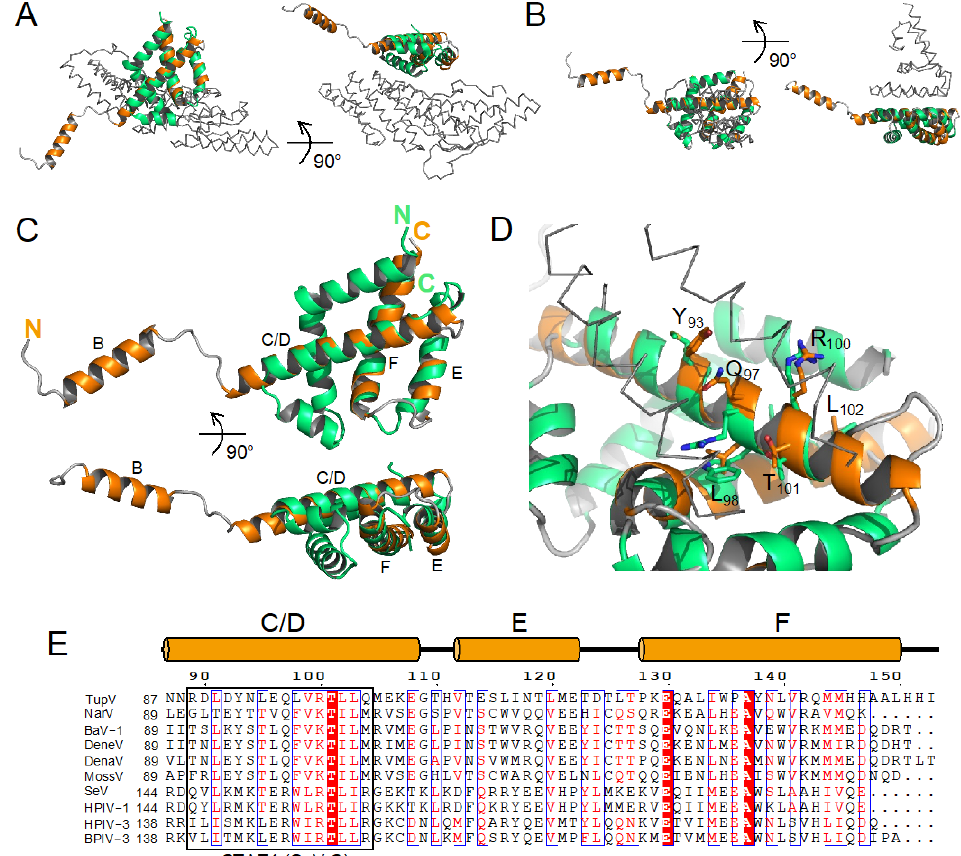
Figure 4. Superposition with the C-terminal domain of Sendai virus C protein. ( A ) Superposition in two orthogonal orientations of the C-terminal domain of TupV C protein with the C-terminal domain of SeV C protein complexed with the BRO-1-like domain of the protein Alix (PDB ID: 6KP3). TupV C is shown in orange, SeV C in green and the BRO-1-like domain of Alix in a grey ribbon. ( B ) Superposition in two orthogonal orientations of the C-terminal domain of TupV C protein with the C-terminal domain of SeV C protein in complex with the N-terminal domain of STAT1 (PDB ID: 3WWT). TupV C is shown in orange, SeV C in green, and STAT1 in a grey ribbon. ( C ) Superposition in two orthogonal orientations of TupV C (in orange) and SeV C (in 3WWT) taken from its complex with STAT1 (in green). ( D ) Close up of the superposition of TupV C and SeV C (in 3WWT) showing the orientation of conserved residues in both proteins. The labeled residues are those of TupV C protein. STAT1 is shown in grey ribbon. ( E ) Sequence alignment of Narmovirus and Respirovirus C proteins. Members of the Narmovirus genus and their UniProt accession number are the same as in Figure 2A, members of the Respirovirus genus are: SeV-Sendai virus-Q38KG9; HPIV1-human parainfluenza virus 1-Q8QT30; HPIV3-human parainfluenza virus 3-Q81077; BPIV1-bovine parainfluenza virus 3-P06164. The orange cylinders above the MSA indicate the location of helices in the crystal structure of TupV C. The black box indicates residues of SeV C that interact with STAT1.